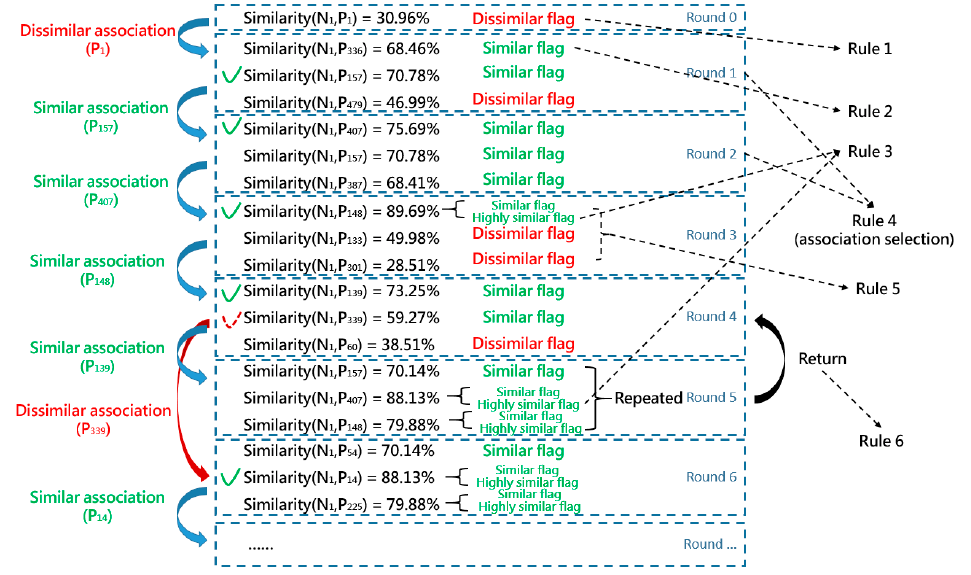
Figure 11. Examples of complying with Rules 1–6.